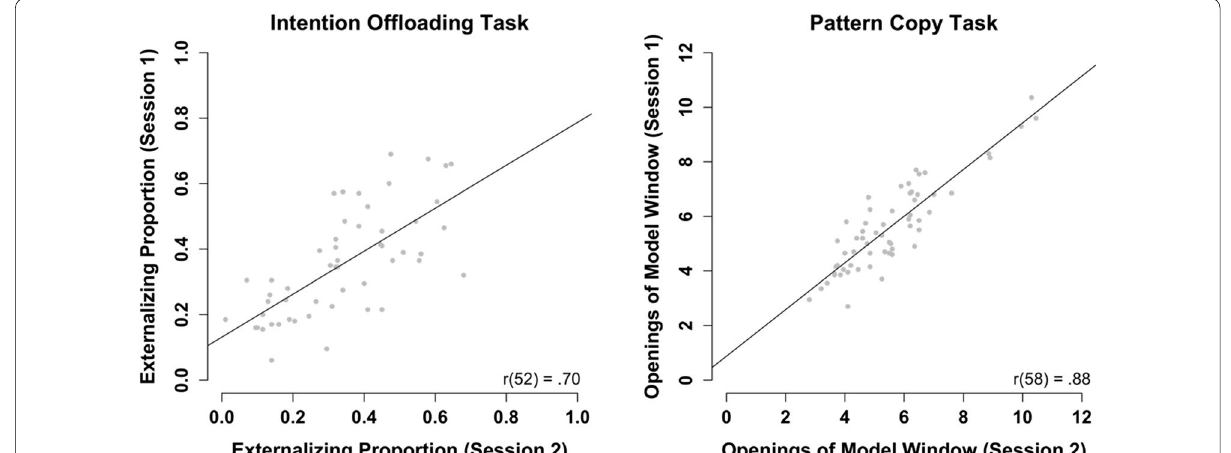
Fig. 3 Reliability estimates of offloading behavior. The left panel displays the correlation of individual differences in the externalizing proportion in the intention offloading task. The right panel displays the correlation of individual differences in the number of openings of the model window in the pattern copy